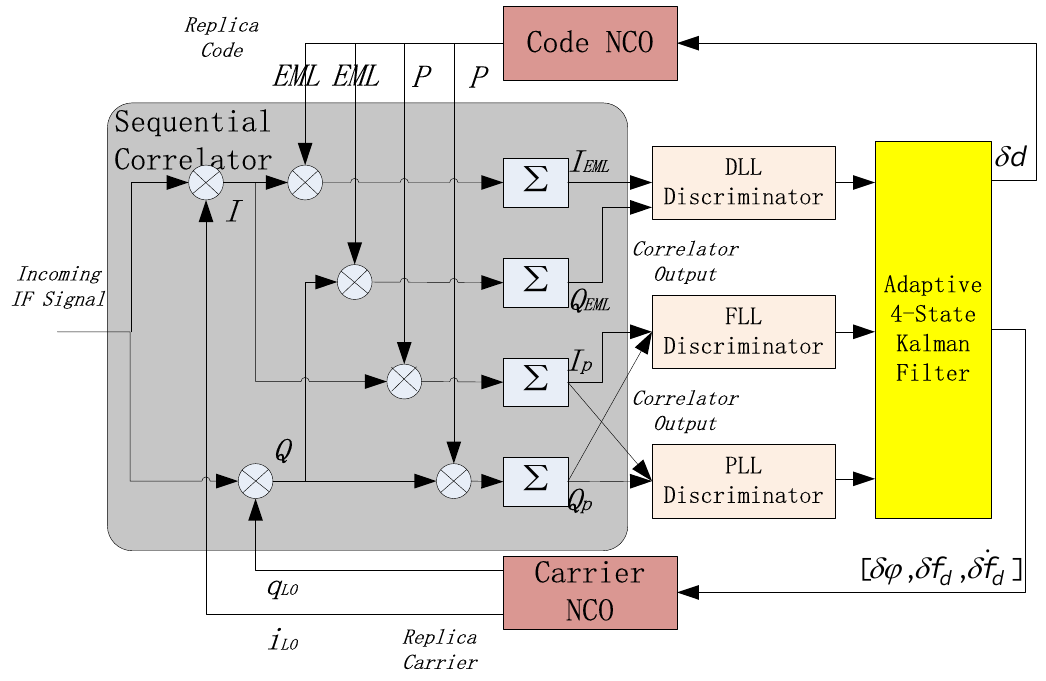
Figure 3. Block diagrams of adaptive four-state KF-based tracking strategy.